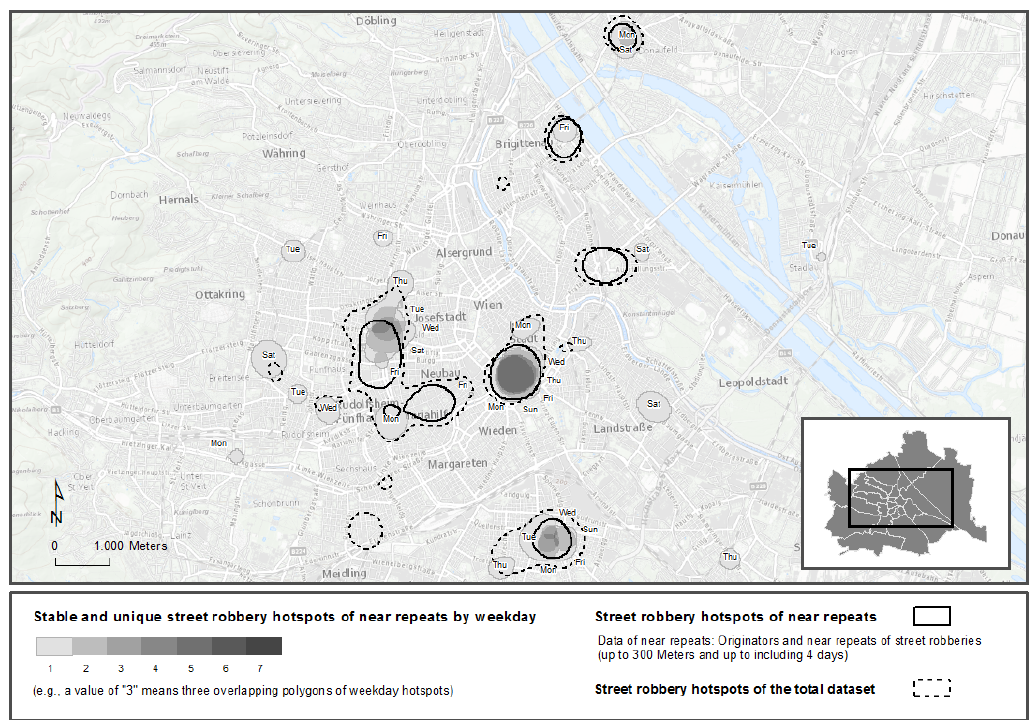
Figure 4. Street robbery hotspots of near-repeats from 2:00 p.m. to 9:59 p.m. by weekday.